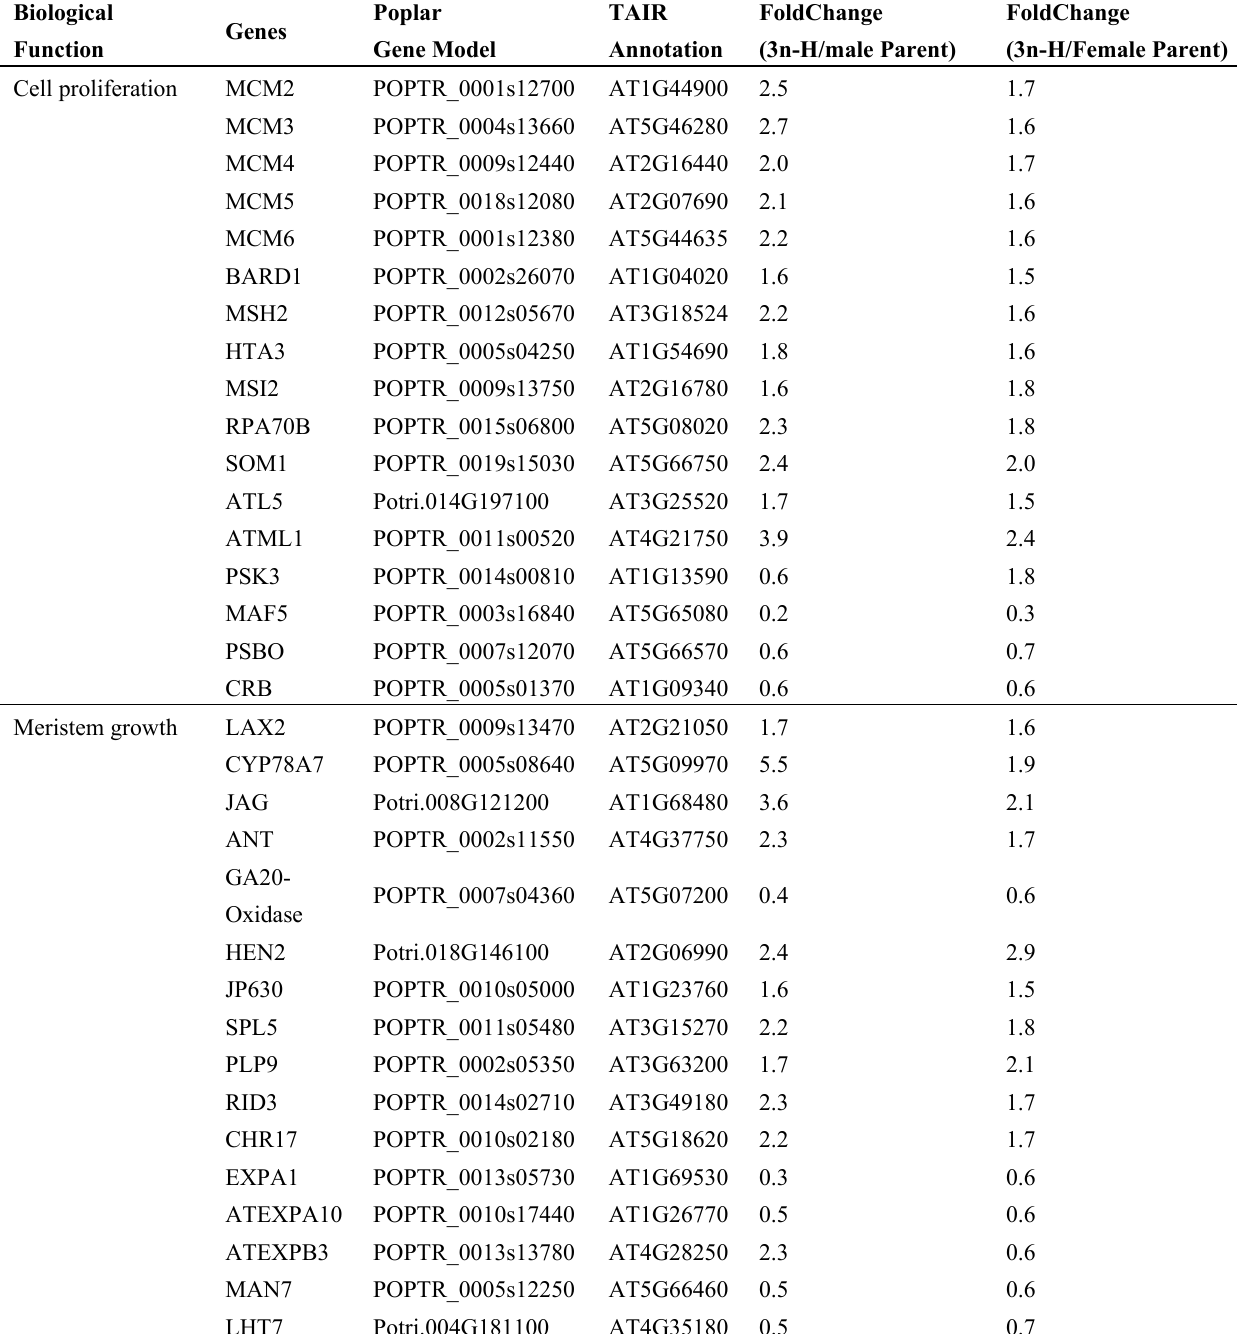
Table 3. Cell differentiation- and meristem development-related genes preferentially expressed in high-growth allotriploid Populus progeny genotypes (PMR-H) compared to their diploid